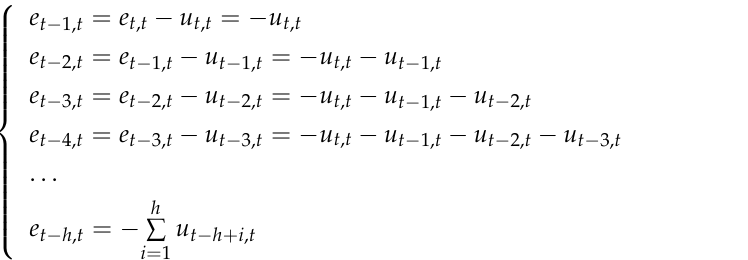
1 q − in the previous period.